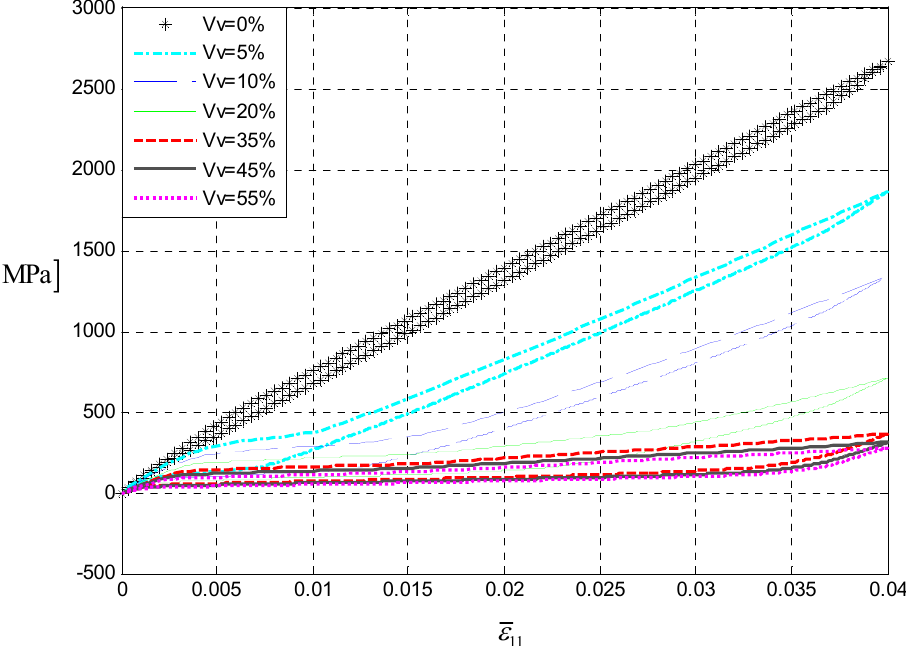
Figure 3: Mechanical responses of the porous UCs along